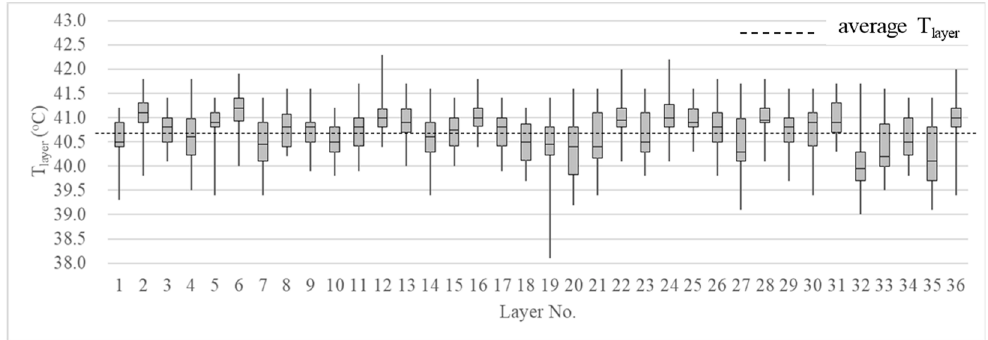
Figure 7. Body surface temperature of hens.